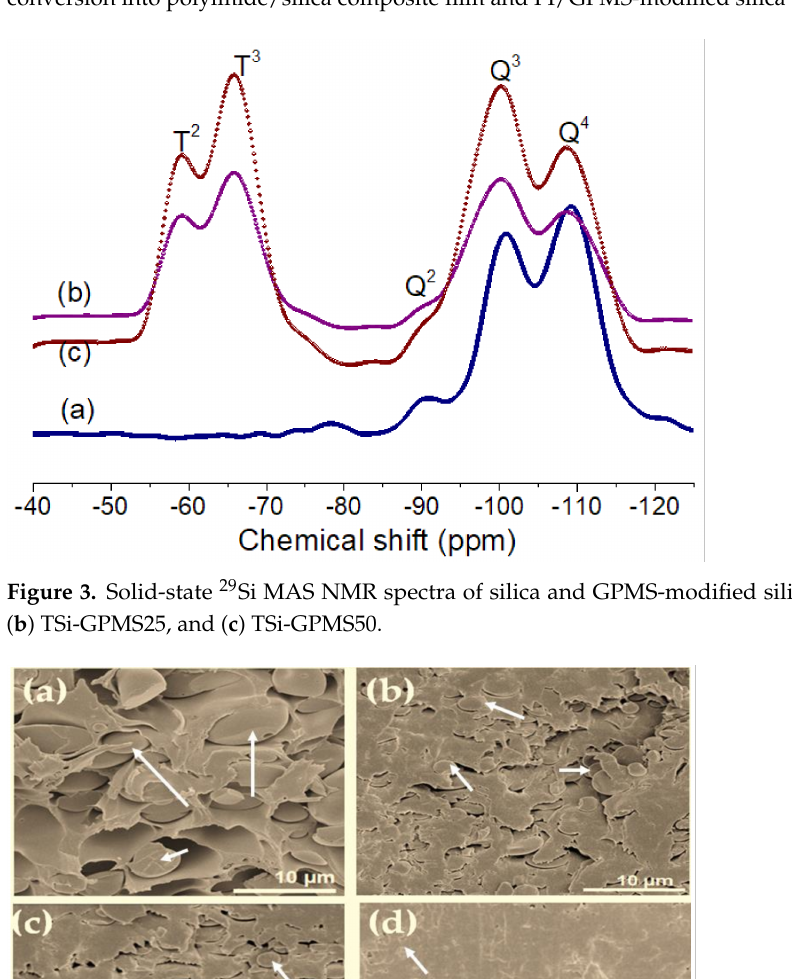
Figure 2. Synthesis of silica/GPMS-modified containing BPDA-PDA PAA composite solution and its conversion into polyimide/silica composite film and PI/GPMS-modified silica composite film.